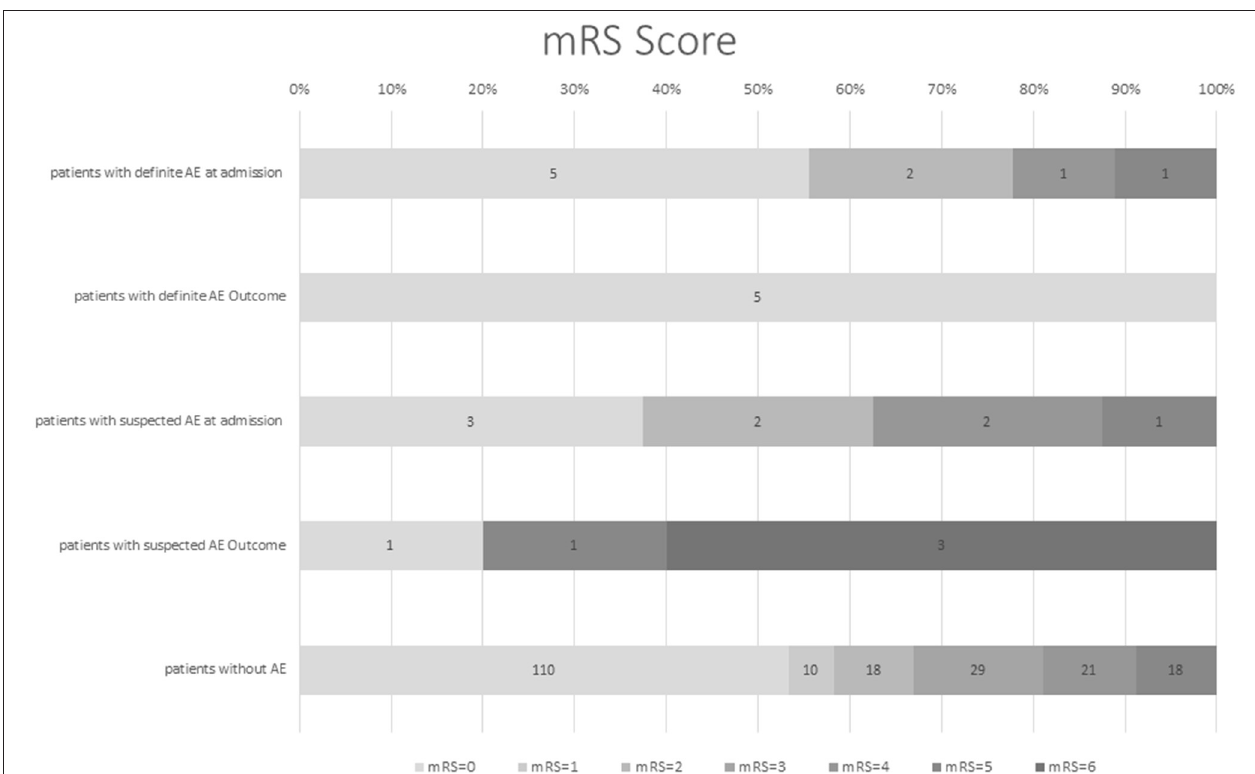
FIGURE 2 | Modified Rankin scale score (mRS) of patients with definite AE and suspected AE at first hospital admission and FU in comparison with patients with late-onset seizures due to another etiology. Modified Rankin scale at hospital admission was low for patients with definite and suspected AE (71% with mRS ≤ 2), which decreased to 60% with mRS ≤ 2 at last FU [mean follow-up time of 40 months (range 6–102)]. Outcome was favorable for non-paraneoplastic and definite AE; outcome in paraneoplastic and suspected AE was worse. However, the generalizability of these study results is limited by the small number of patients. mRS, modified Rankin scale, AE, autoimmune encephalitis, FU,